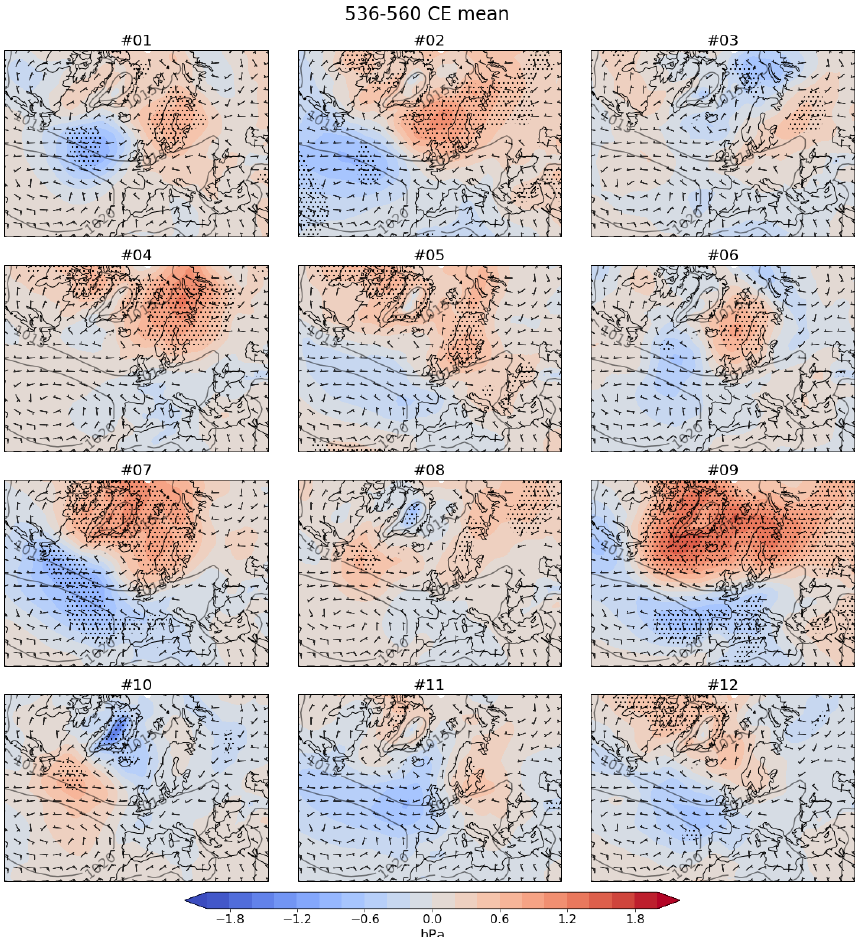
Figure 6. SLP anomaly and absolute 10m wind maps for the mean growing season for 536–560CE for the individual ensemble members. Anomalies are calculated with respect to 1–1850CE climatology, which is given in contours. The 2 σ significant areas are stippled. Wind barbs are shown for 1, 5, and 10ms − 1